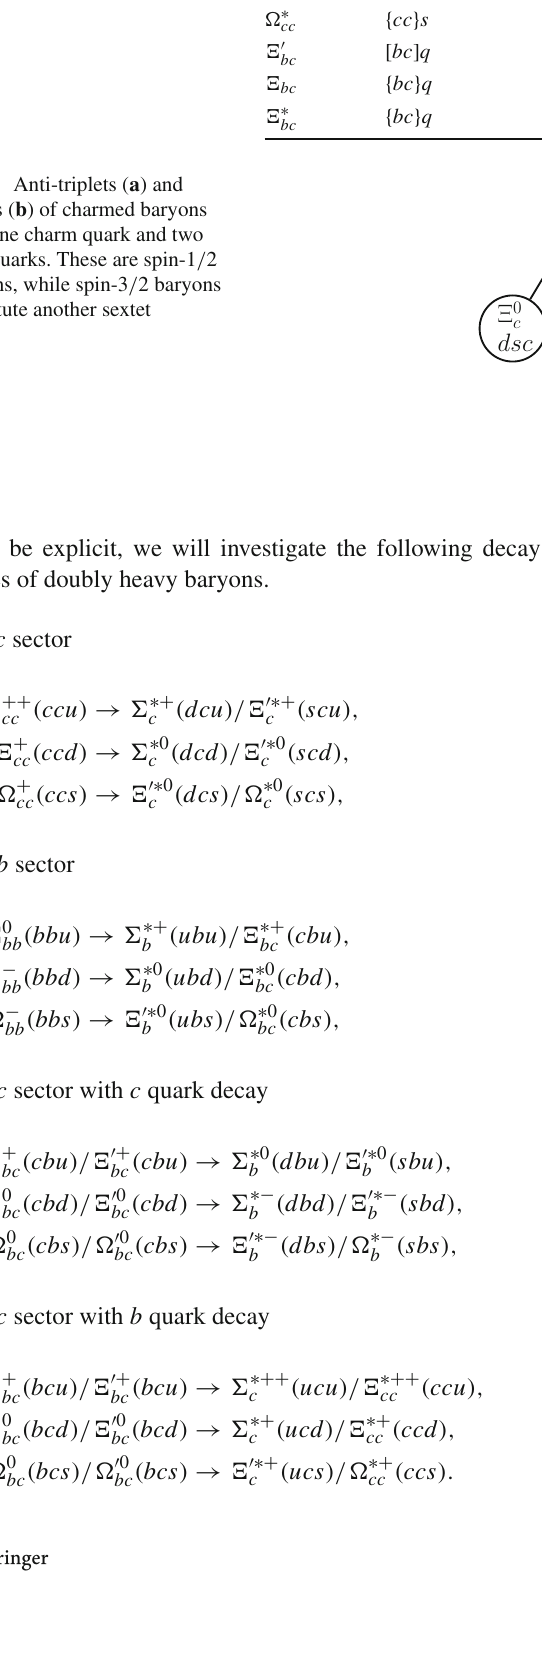
quark content for the ground state of doubly heavy baryons. The S π denotes the spin of the h heavy quark system. The light quark q corresponds to u , d quark